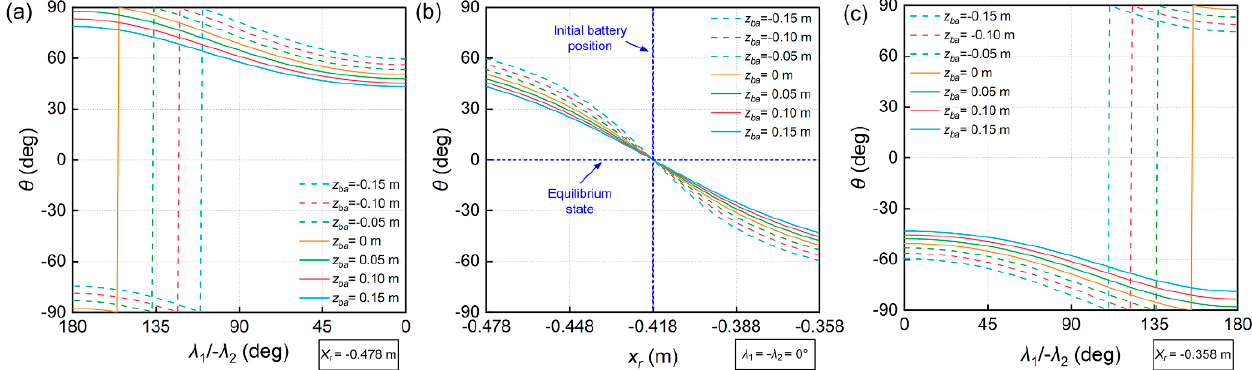
Figure 17. The regulation range of θ for different z ba with m ba equal to 3.0 kg: ( a ) θ vs. λ 1 / − λ 2 ( x r = − 0.478 m); ( b ) θ vs. x r ( λ 1 / − λ 2 = 0°); ( c ) θ vs. λ 1 / − λ 2 ( x r = − 0.358 m).